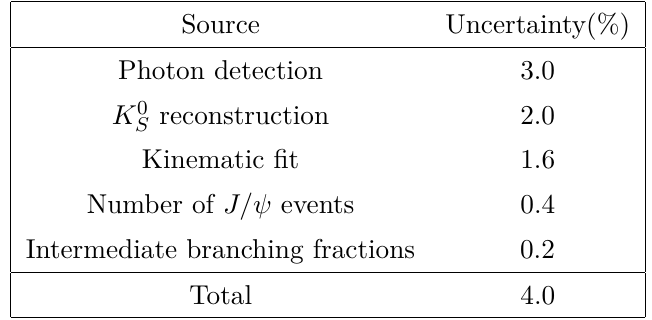
Table 5 . Summary of systematic uncertainties related to event selection for the determination of the branching fraction (relative uncertainties).